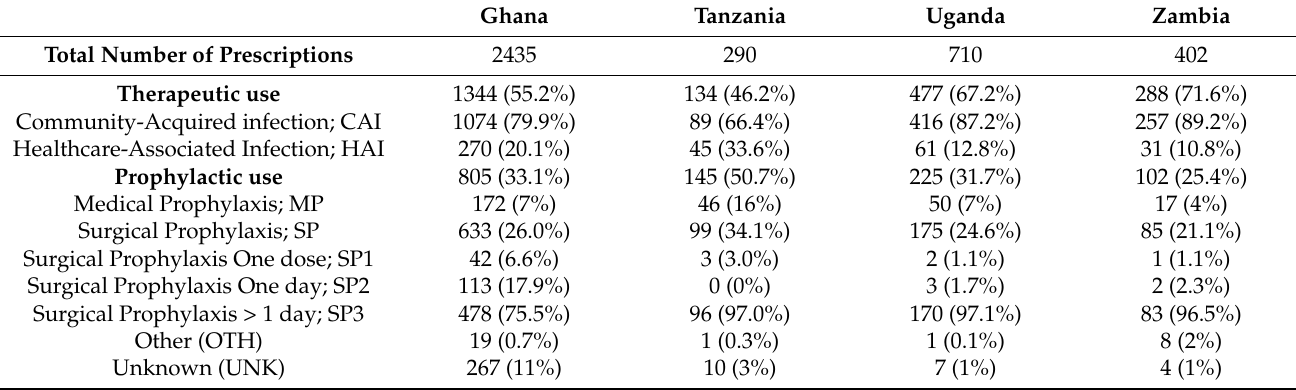
Table 4. Type of indication for antimicrobial